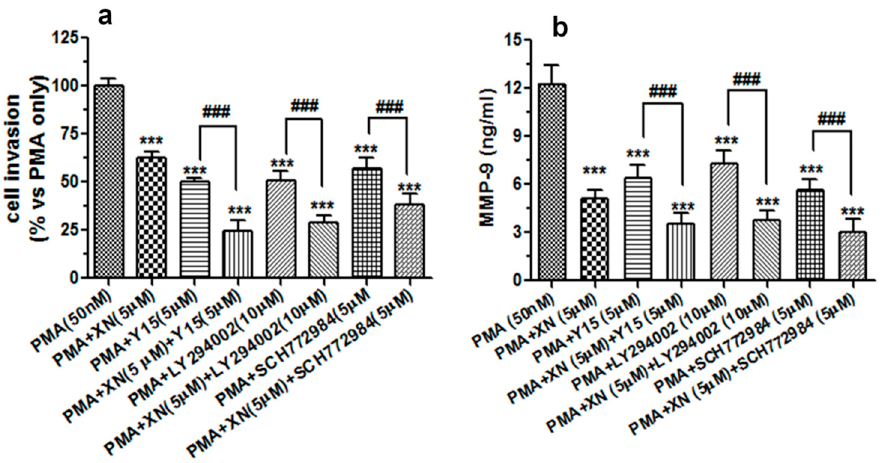
Figure 7. The XN-mediated suppression of the PMA-induced invasive potential of A549 cells and MMP-9 production is associated with alteration of FAK/AKT and MAPK/ERK signalling pathways. The A549 cells were exposed to a single treatment (5 μ M XN, LY294002, Y15, or SC772984) or a combination treatment (XN + Ly294002, XN + Y15, or XN + SC772984) for 4 h, and then incubated in the presence of PMA (50 nM) for 24 h. ( a ) The invasive ability of the treated cells was studied using the Transwell in vitro invasion assay. The invasion of the untreated PMA-stimulated cells was established as 100%. *** p < 0.001 compared to the PMA-stimulated cells; ### p < 0.001; one-way ANOVA test. ( b ) After the single or combination treatment (as indicated above), the supernatants from the PMA-stimulated cells were subjected to the ELISA assay to analyse the levels of the MMP-9 protein. The results are the mean ±SD from three independent experiments. *** p < 0.001 compared to the PMA-treated cells, ### p < 0.001; one-way ANOVA test.